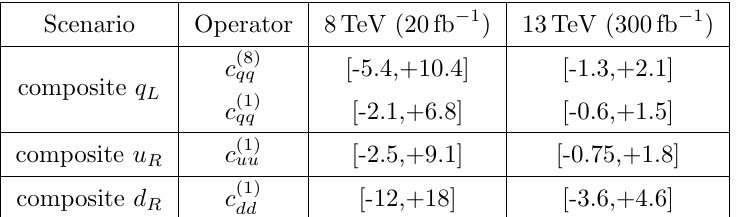
Table 7 . 95% CL projected bound on the coe(cid:14)cient, c I , of 4 quark operators de(cid:12)ned as